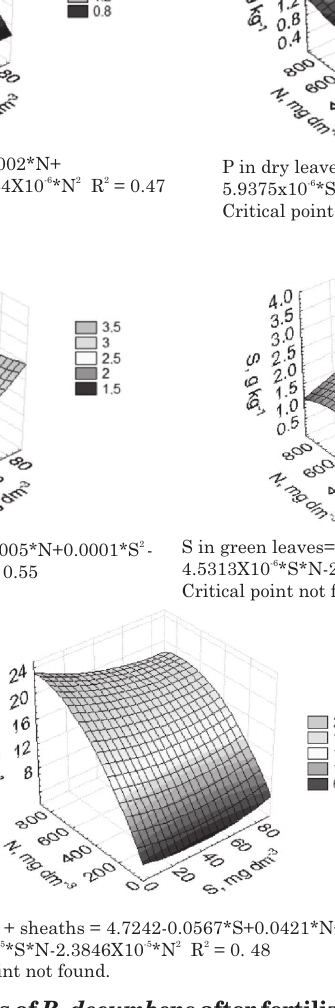
Figure 3. Nutrient contents in shoots of B. decumbens after fertilization with nitrogen and sulfur.